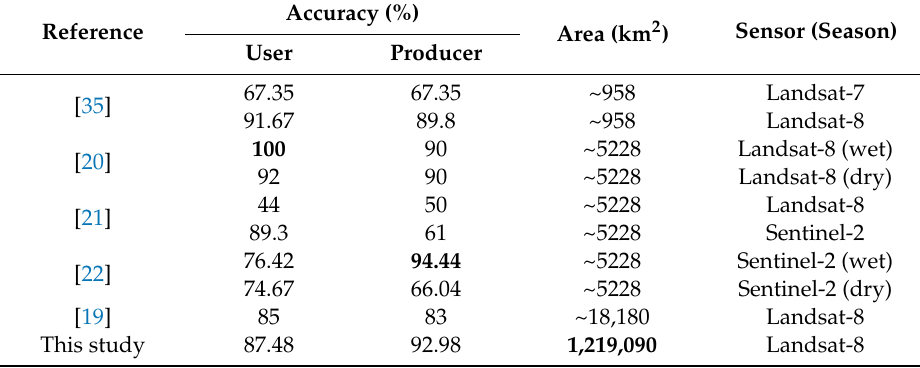
Table 3. Comparison of user and producer accuracy scores between studies that have mapped water hyacinth. The area of imagery (km 2 ) that water hyacinth was mapped is provided. The area estimates (~) were not provided in the studies and were based on the bounding box of the georeferenced output classification map found within each study. The highest accuracy and greatest area shown in bold